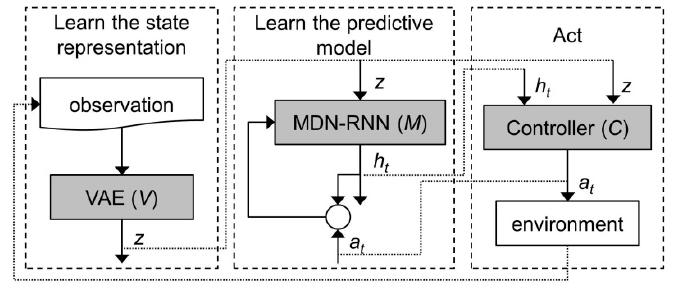
Figure 10. Flow diagram of the agent model.